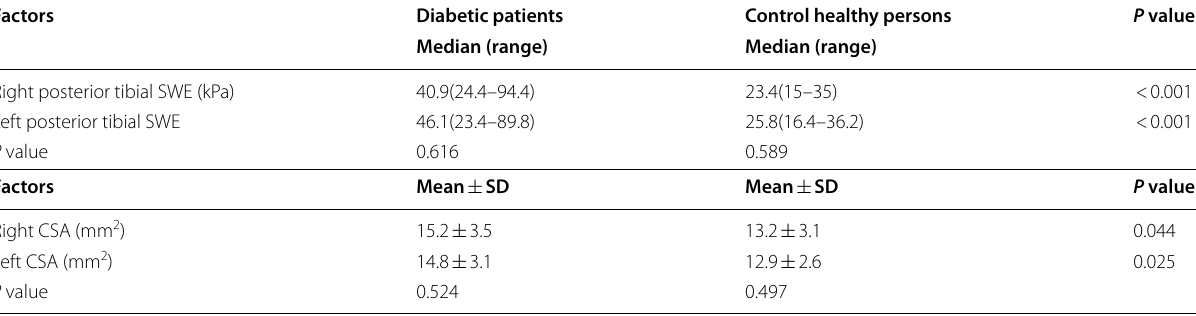
Table 1 Shear wave elastography (SWE) quantitative parameter (kilopascals) and cross-sectional area (CSA) in millimeter square among diabetic patients and control healthy